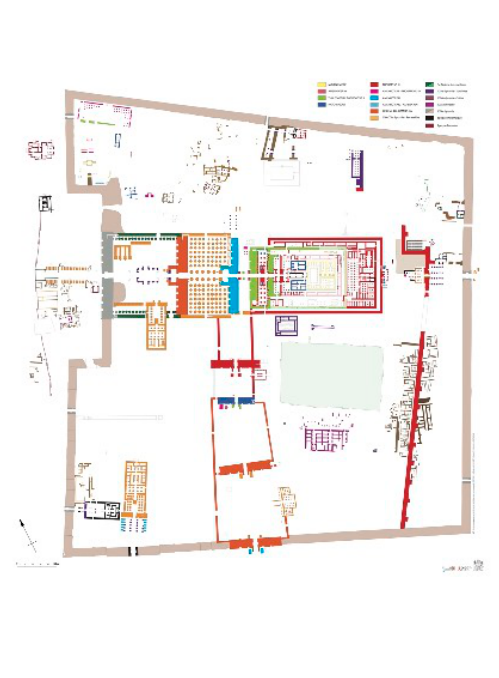
Figure 1 . Chronologic map of